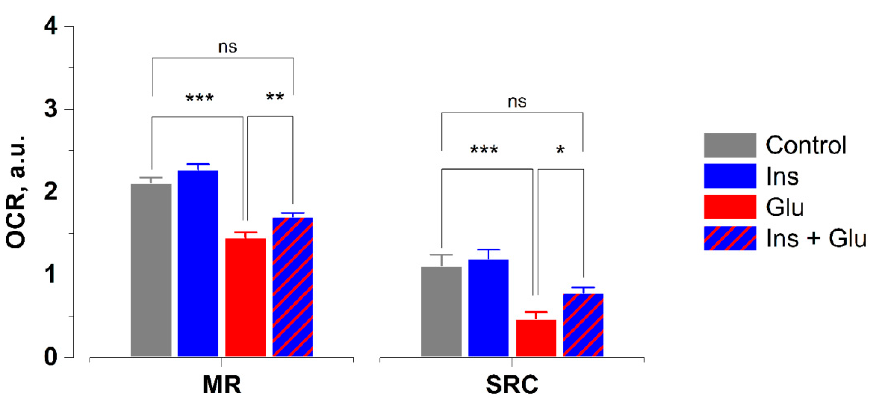
Figure 4. Insulin improves oxygen consumption rates (OCR) in rat cortical neurons exposed to glutamate. MR—maximal respiration. SRC—spare respiratory capacity. Data are the mean ± SEM of six to fourteen independent experiments. * p < 0.05, ** p < 0.01, *** p < 0.001 (Kruskal–Wallis followed by Dunn’s post-test). ns—non significant.